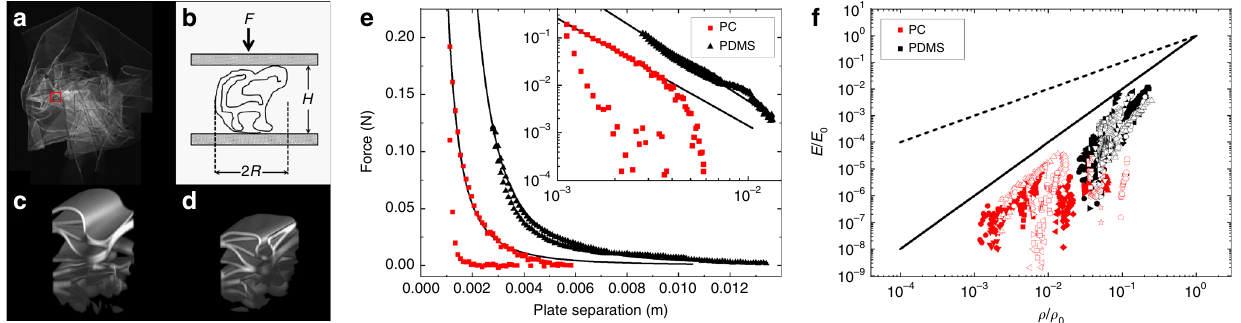
Fig. 2 Compression measurements of crumpled matter. a Confocal microscopic image of a crumpled (69.5 mm × 46.1 mm × 79.4 μ m) polydimethylsiloxane (PDMS) sheet in index-matching glycerine/water mixture. b Basic geometry of crumple compression experiment. c A three-dimensional rendering of the confocal data from the 1.3 mm × 1.3 mm red square indicated in a , in this case H = 2.8 mm. d Same location as c. under a compression of H = 1.8 mm. e Force displacement data for a 43 mm × 40 mm × 86.5 μ m PDMS fi lm (black triangles) and a 16 mm × 22 mm × 2 μ m thick polycarbonate fi lm. Inset shows the same data on a log/log axis. Both data sets are well fi t by the power law F ¼ F 0 H α , where F 0 and α are fi t constants. f Normalized modulus data from several different crumpled polycarbonate (PC) (red — various symbols) and PDMS (black — various symbols) fi lms plotted as a function of normalized density. Speci fi cally, E ¼ ð F = π R 2 Þ = ½ð H (cid:2) H 0 Þ = H (cid:4) and ρ ¼ L 2 h = H π R 2 , where L is the average length and width of the crumpled sheet, and H 0 is the cell gap at the beginning of compression. The normalization constants E 0 and ρ 0 refer to the Young ’ s modulus and density of the material making up the fi lm (bulk PC or PDMS), respectively. The two solid lines are the ideal stretching (dashed) and ideal bending (solid) limits 2